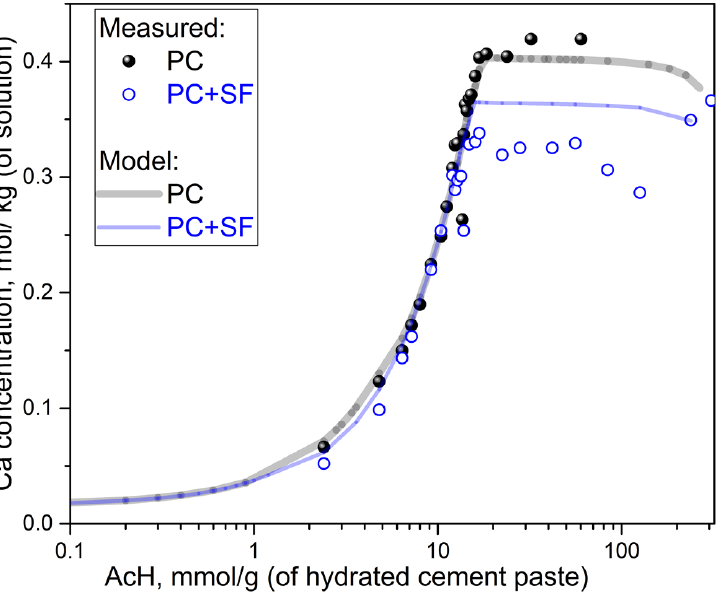
Figure 3. Concentration of dissolved calcium as a function of acid concentration, both for PC and PC + SF.